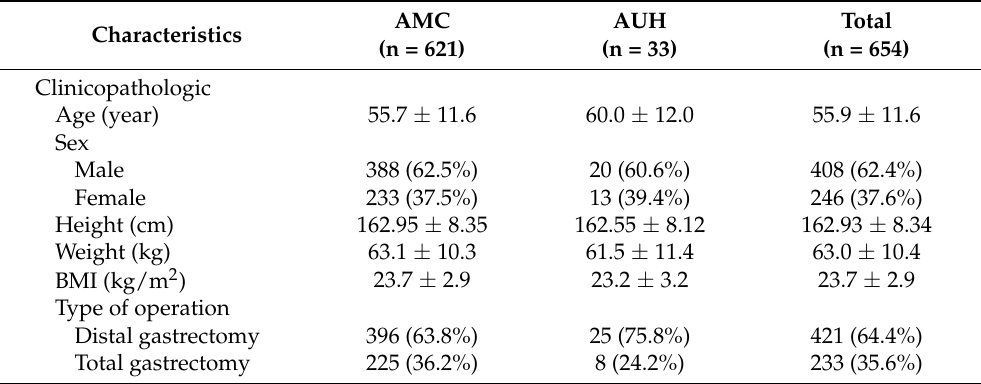
Table 1. Patient